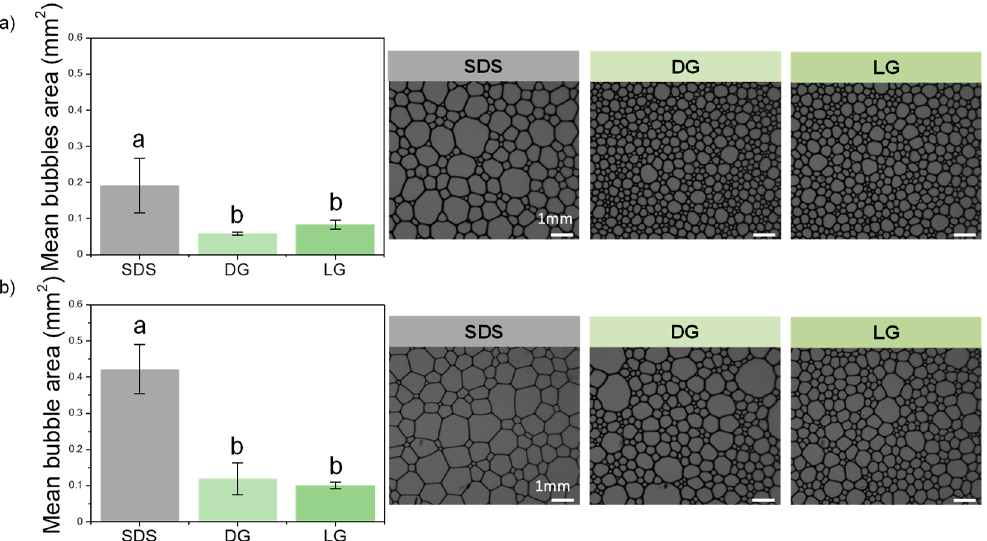
Figure 5. Mean bubbles area of the foams produced with SDS, DG, and LG with the corresponding microscopic pictures: ( a ) before the foam passed through the duct containing the plate contaminated with spores and ( b ) after the foam passed through the duct. The scale bar represents 1 mm for all the foam pictures. The small letters a–b indicate groups of statistical differences according to Tukey’s test ( p < 0.05).